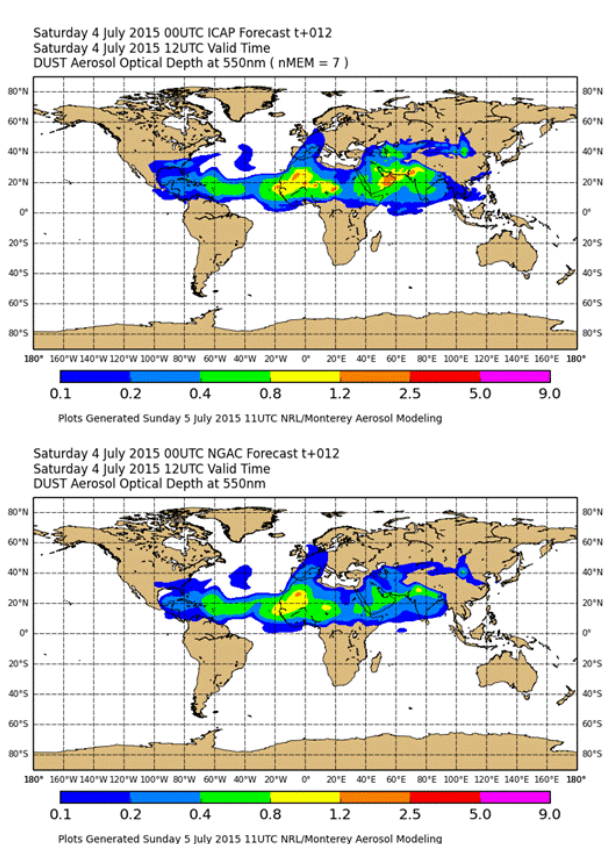
Figure 7. Dust AOD valid at 12:00UTC, 4 July 2015 for ICAP multi-model ensemble (top) and NGAC V1.0 (bottom). The ensem- ble is based on seven members, including the models from NCEP (NGAC V1.0), GMAO, ECMWF, NRL, JMA, UKMO, and BSC. These figures are produced by the Naval Research Laboratory.